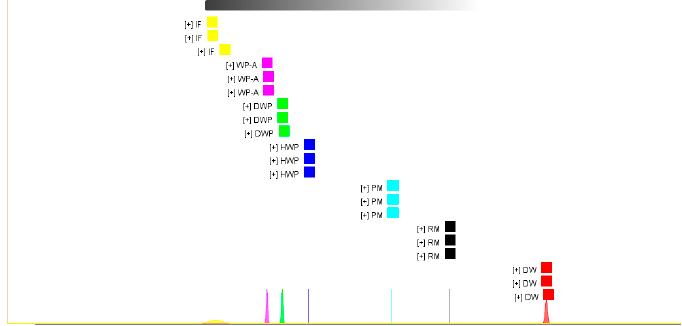
Figure 4. The results of the fingerprint similarity analysis (FSA). RM, raw milk; PM, pasteurized milk; DW, demineralized whey; DWP, demineralized whey powder; HWP, hydrolyzed whey protein powder; WPA, whey protein powder with added alpha-lactalbumin; IF, infant formula.